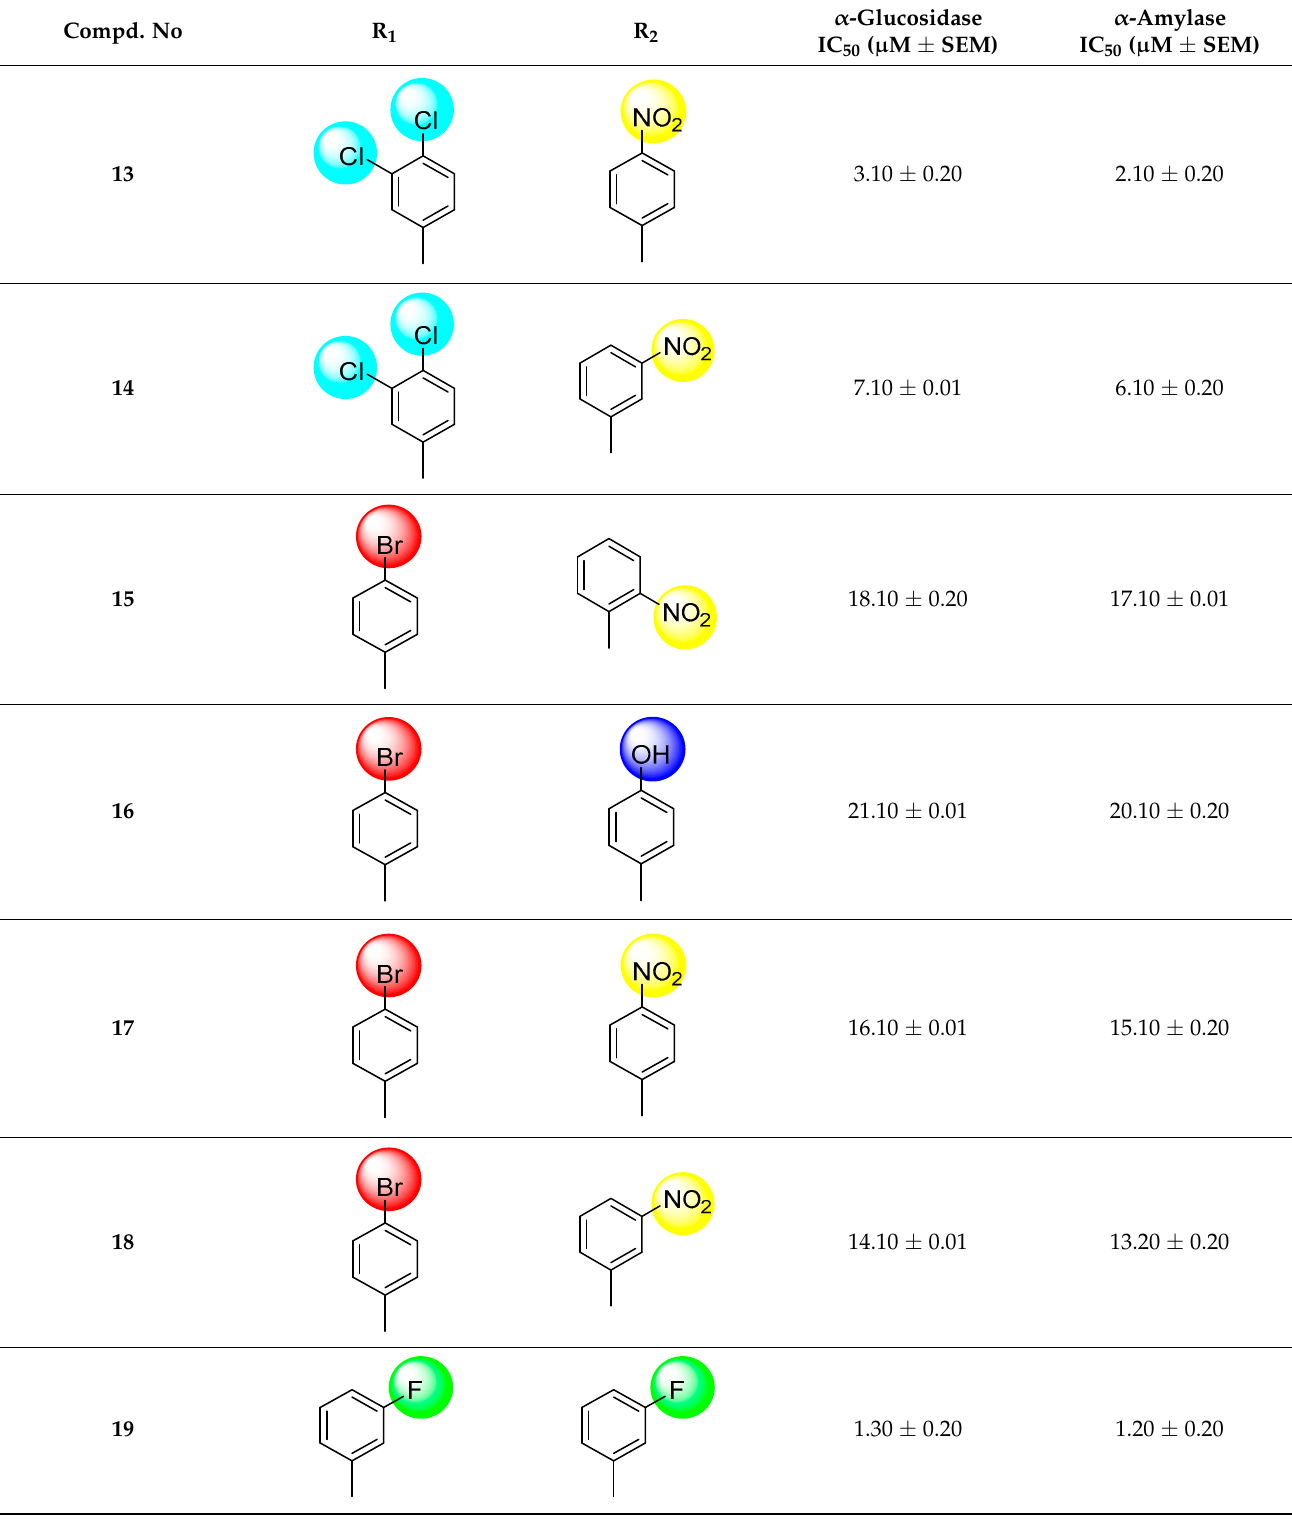
bon, which is attached to (C-C=N). Table 1. Different substituents and α -glucosidase and α -amylase inhibitory activities of benzimid- azole bearing thiosemicarbazone derivatives ( 7–21 ).